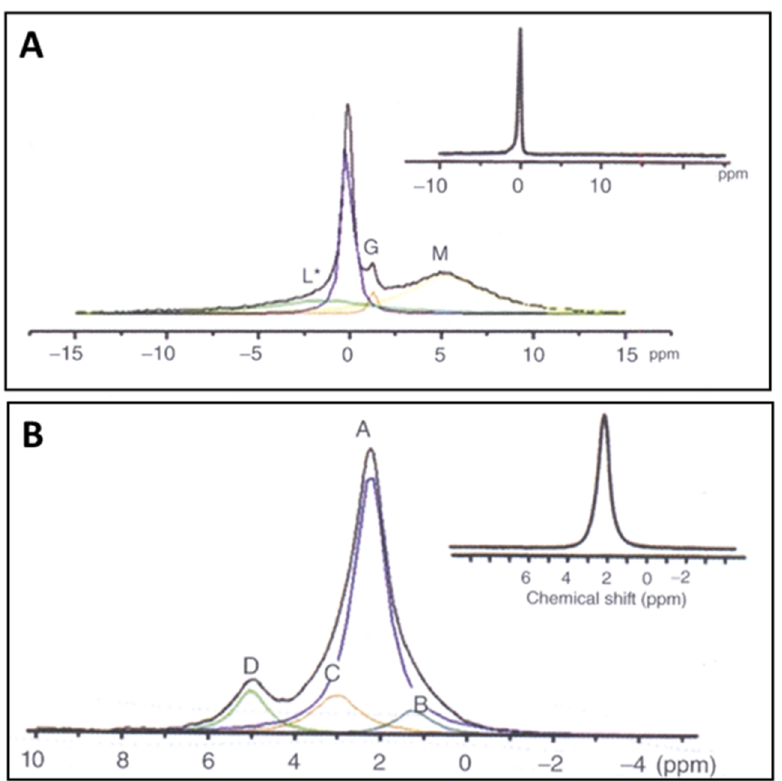
Figure 6. ( A ): 1 H-MAS NMR spectrum of as-sprayed HAp. For band assignment see text. ( B ): 31 P- MAS NMR spectrum of as-sprayed HAp [52,53]. For band assignment see text. The insets show spectra of highly ordered, stoichiometric hydroxylapatite [21]. Bruker AMX 400 (rotation rate 12.5 kHz, pulse length 2 µs, repetition rate 200 s). Dept. of Optic and Quantum Electronics, University of Jena, Germany © Reprinted with permission from R.B. Heimann and H.D. Lehmann, Biomedical Coatings for Medical Implants (Wiley-VCH, Weinheim, 2015). Copyright 2015